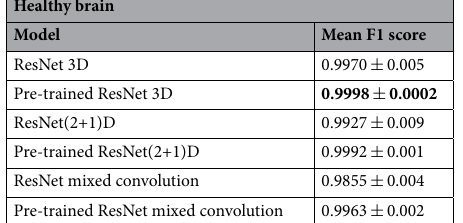
Table 4. Healthy brain model comparison (*denotes the overall winning model).